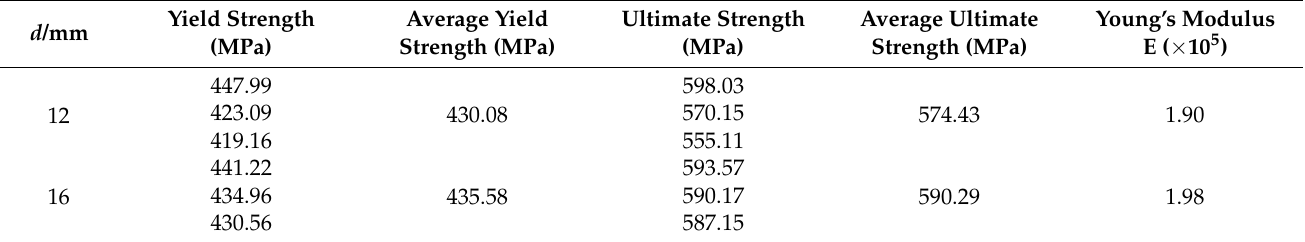
Table 3. Mechanical properties of rebar.